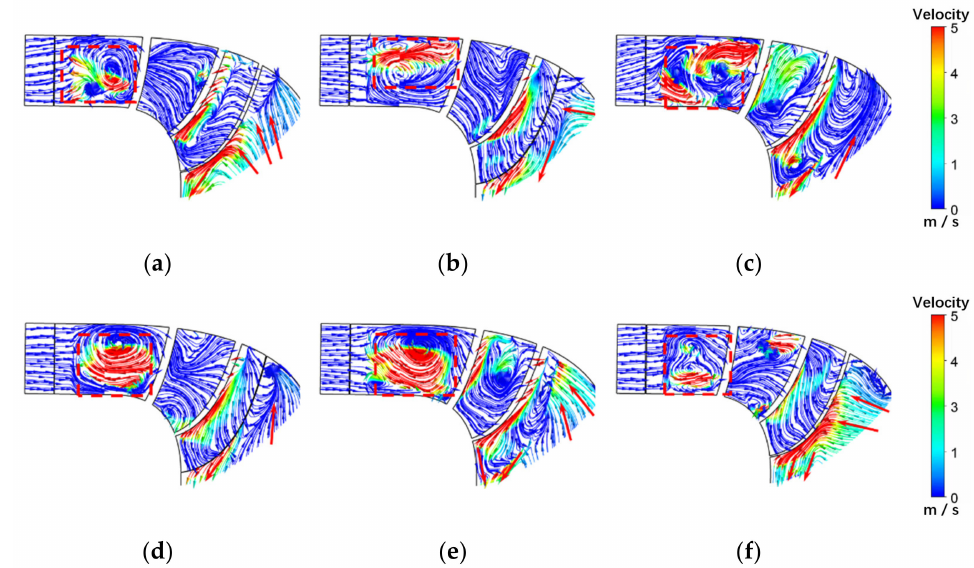
Figure 15. Flow pattern evolutions on a vertical section during the regulating period in Case1. ( a ) t = 31 s; ( b ) t = 39 s; ( c ) t = 47 s; ( d ) t = 54 s; ( e ) t = 63 s; ( f ) t = 71